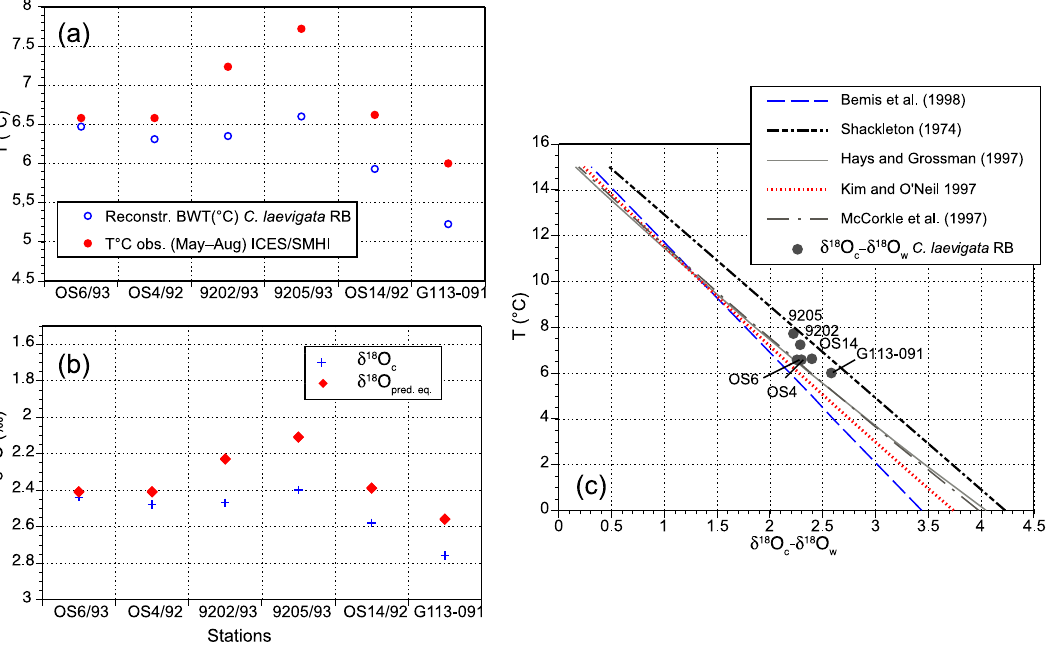
Figure 4. Comparison of reconstructed temperatures and δ 18 O values measured in stained C. laevigata from the core tops collected in Gullmar Fjord (G113-091) and the Skagerrak (OS4, OS6, OS14, 9202, 9205) to hydrographic temperature data (a) and to δ 18 O predicted from the palaeotemperature equation (b) by McCorkle et al. (1997). (c) Temperature vs. δ 18 O c – δ 18 O w , together with the paleotemperature equations from Shackleton (1974), Hays and Grossman (1991), Kim and O’Neil (1997), McCorkle et al. (1997) and Bemis et al.